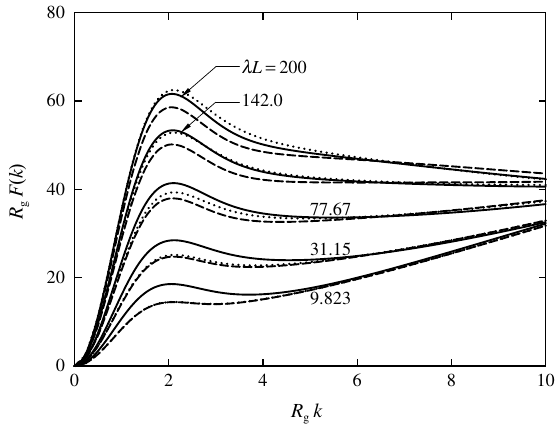
Figure 4. Plots of R g F ( k ) against R g k for the discrete KP rings of the trefoil knot (solid); of the trivial knot (dashed) [8]; and without the topological constraints (dotted) [8], with the indicated values of λ L